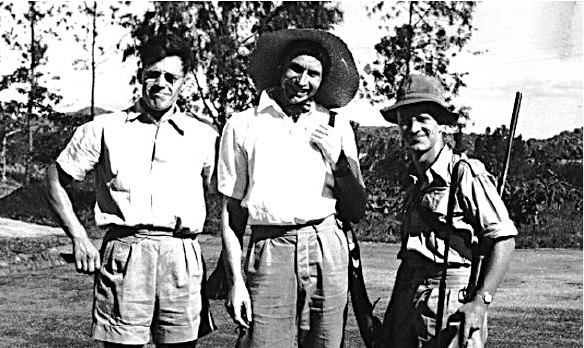
Fig. 1. – Fieldwork in Nigeria, 1957. David Godfrey (left), Kenneth Broomfield (centre) and Bob Killick-Kendrick (right) in 1957 at the West African Institute for Trypanosomiasis Research, Vom, Northern Nigeria. Photograph kindly supplied by David’s daughter, Susan